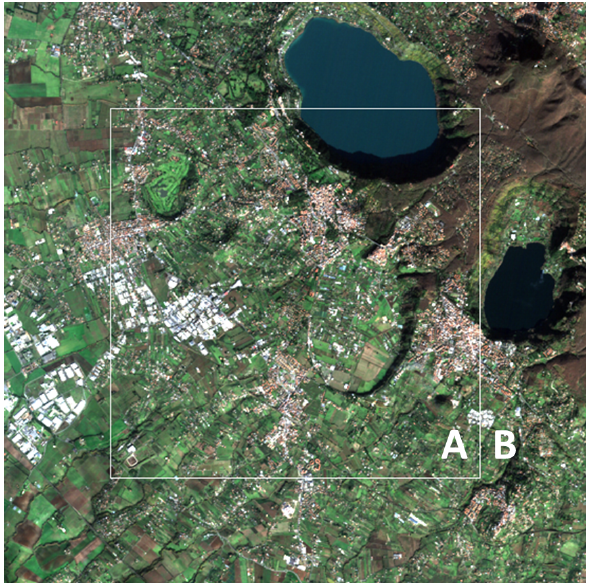
Figure 3. True color combination for the restoration of the area denoted with an A in Fig. 2.